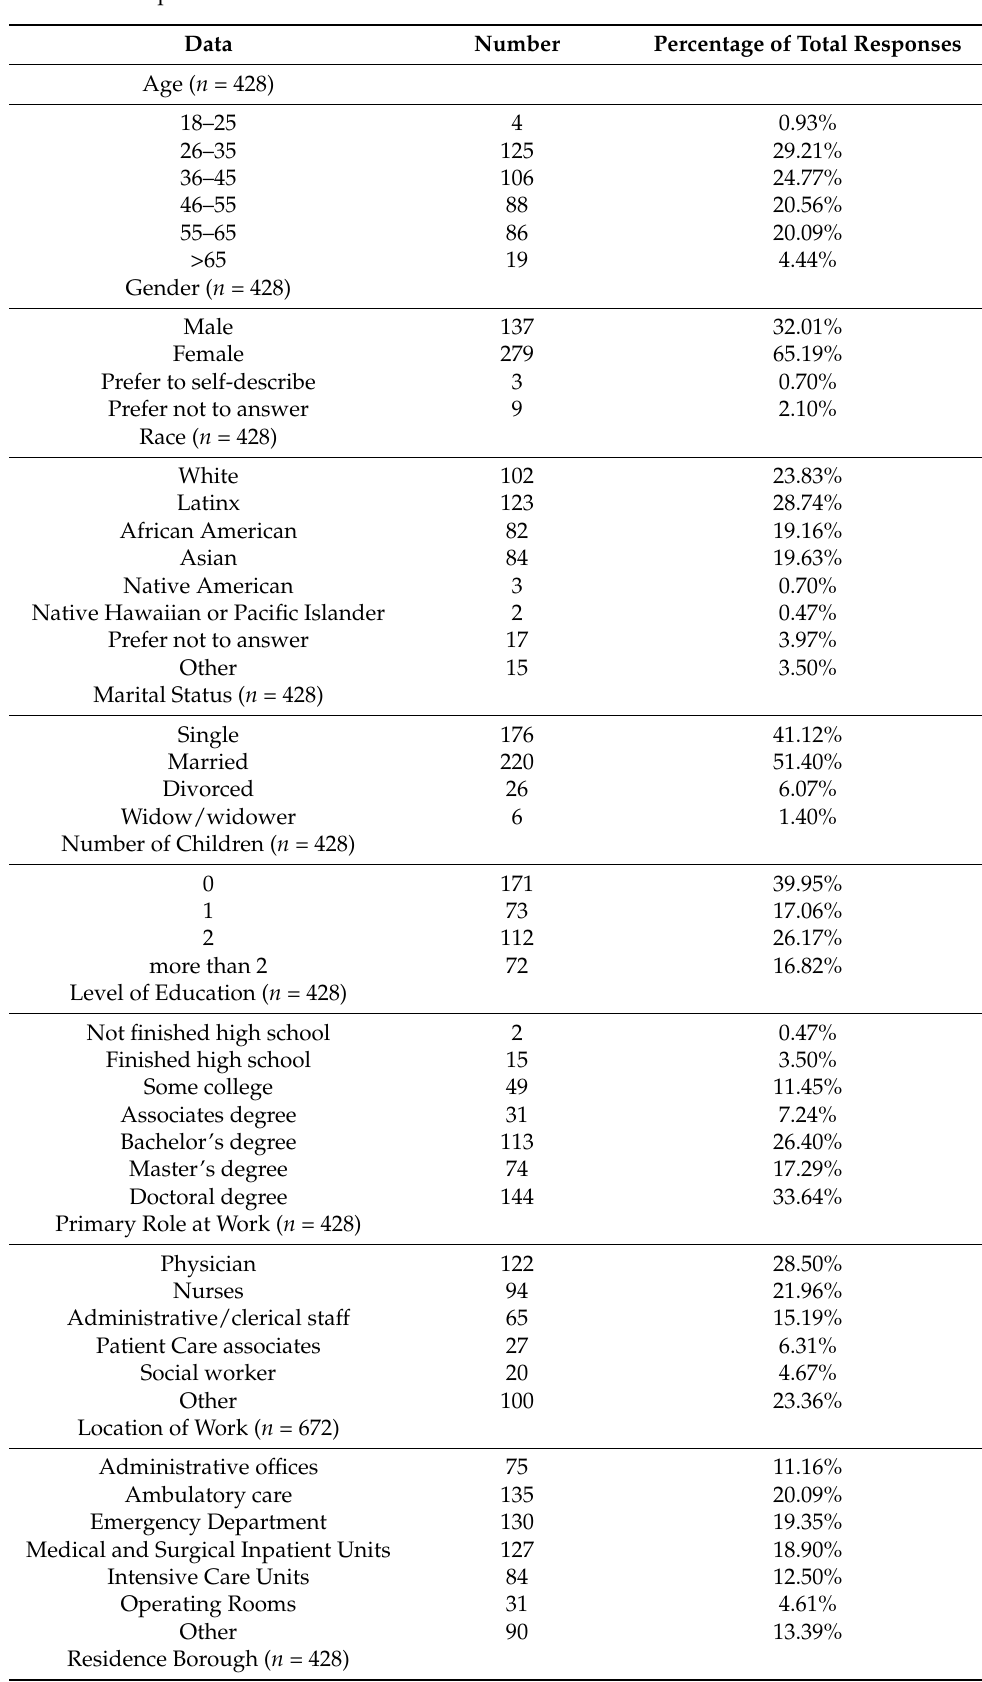
Table 1. Participant